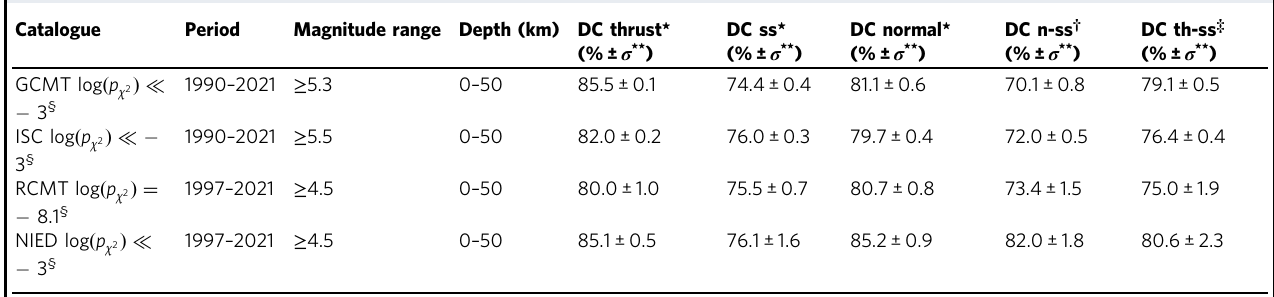
Table 1 Double-couple components of moment tensors in different seismic